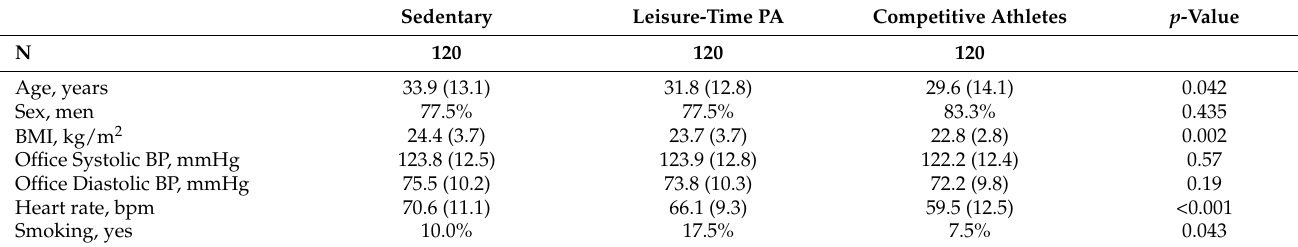
Table 1. Characteristics of the 3 groups of study participants.